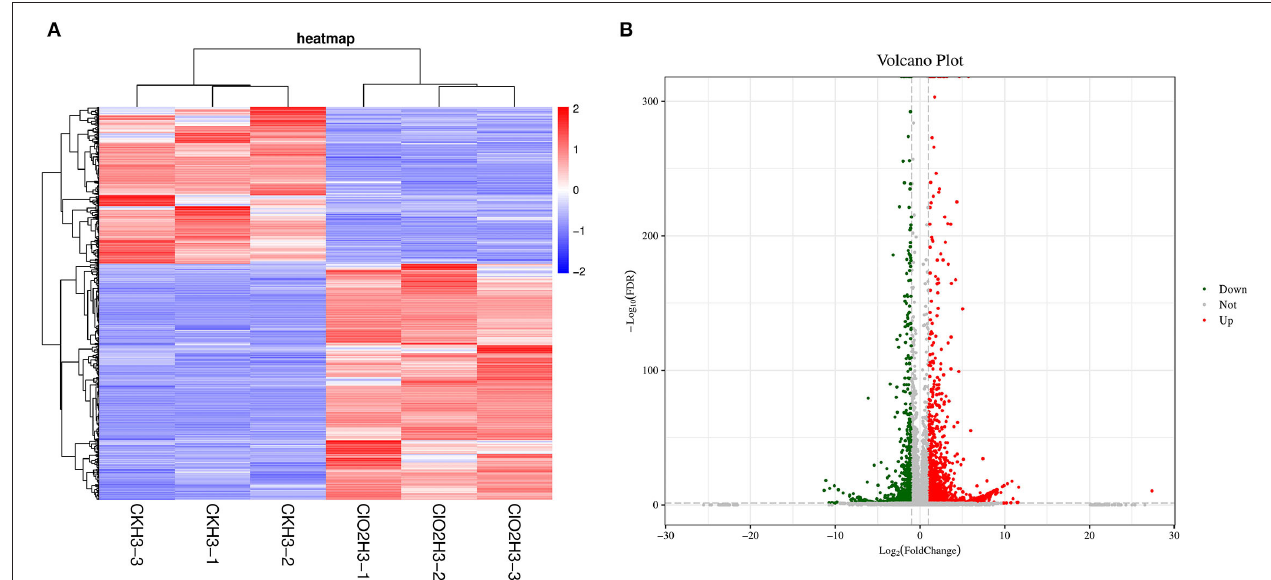
FIGURE 1 | The cluster heat map of the differentially expressed genes (A) and volcanic map (B) in control and ClO 2 treated tubers. Three biological repeats were shown in the figure. CKH3 represents the tubers of safflower treated with sterile water; ClO 2 H 3 represents the flowers of safflower treated with ClO 2